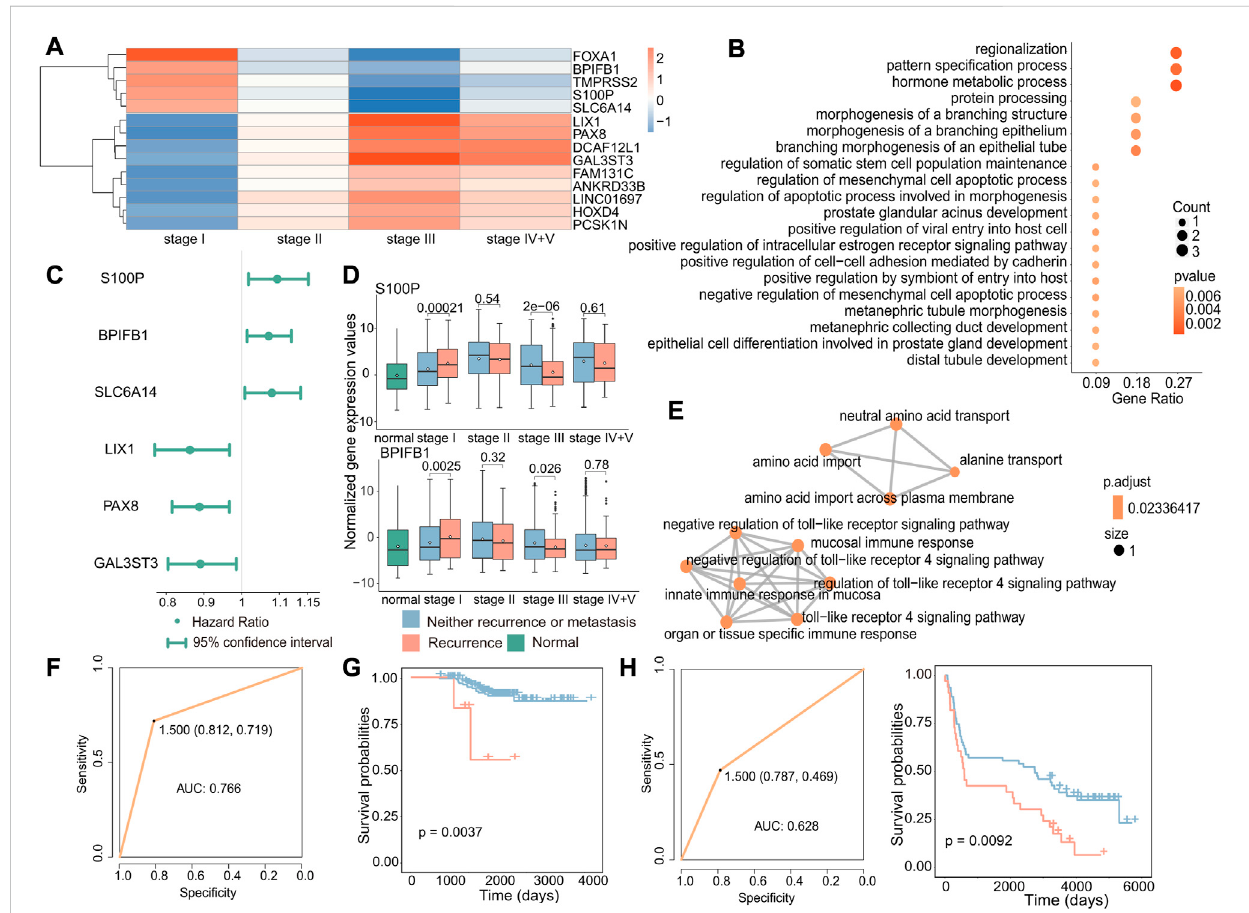
Biomarkersassociatedwithearlyrecurrenceincancer. (A) Heatmapoffold-changevaluesofstage-speci fi cdifferentiallyexpressedgenesinstageI. Red indicates that gene expression was upregulated in recurrent tumors, while blue indicates downregulation in recurrent tumors. (B) GO enrichment analysisofstage-speci fi cdifferentiallyexpressedgenesinstageI.Thesizeofthedotindicatesthenumberofgenesinvolvedinthepathway,andthecolor of the dot indicates the p -value. (C) Cox regression analysis of stage I-speci fi c differentially expressed genes related to prognosis. The point is the value of the hazard ratio, and a value greater than 1 indicates that it was related to poor prognosis. (D) Boxplot of the expression of S100P and BPIFB1 in normal, primary, and recurrent tumor samples. (E) GO enrichment analysis of three genes. Each dot represented a pathway, and the connecting two pointsmeantthatthesamegeneswereinthepathways. (F) Basedonthesethreegenes,theROCcurveoftheclassi fi erconstructedbythesupportvector machinemethod. (G) FortheGSE31210dataset,theKaplan – MeiersurvivalcurveoftheSVMclassi fi cationresult.Redindicatedsamplespredictedtohave recurrence, and blue indicated samples predicted to have no recurrence. (H) For the GSE37745 dataset, the ROC curve of the k-nearest neighbor classi fi er (left) and the survival curve of the classi fi cation result (right). Red indicates samples predicted to have recurrence, and blue indicates samples predicted to have no